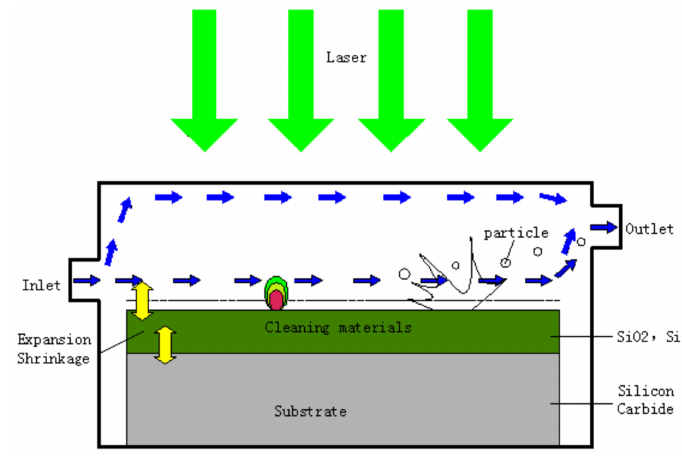
Figure 2. Schematic diagram of gas-assisted laser